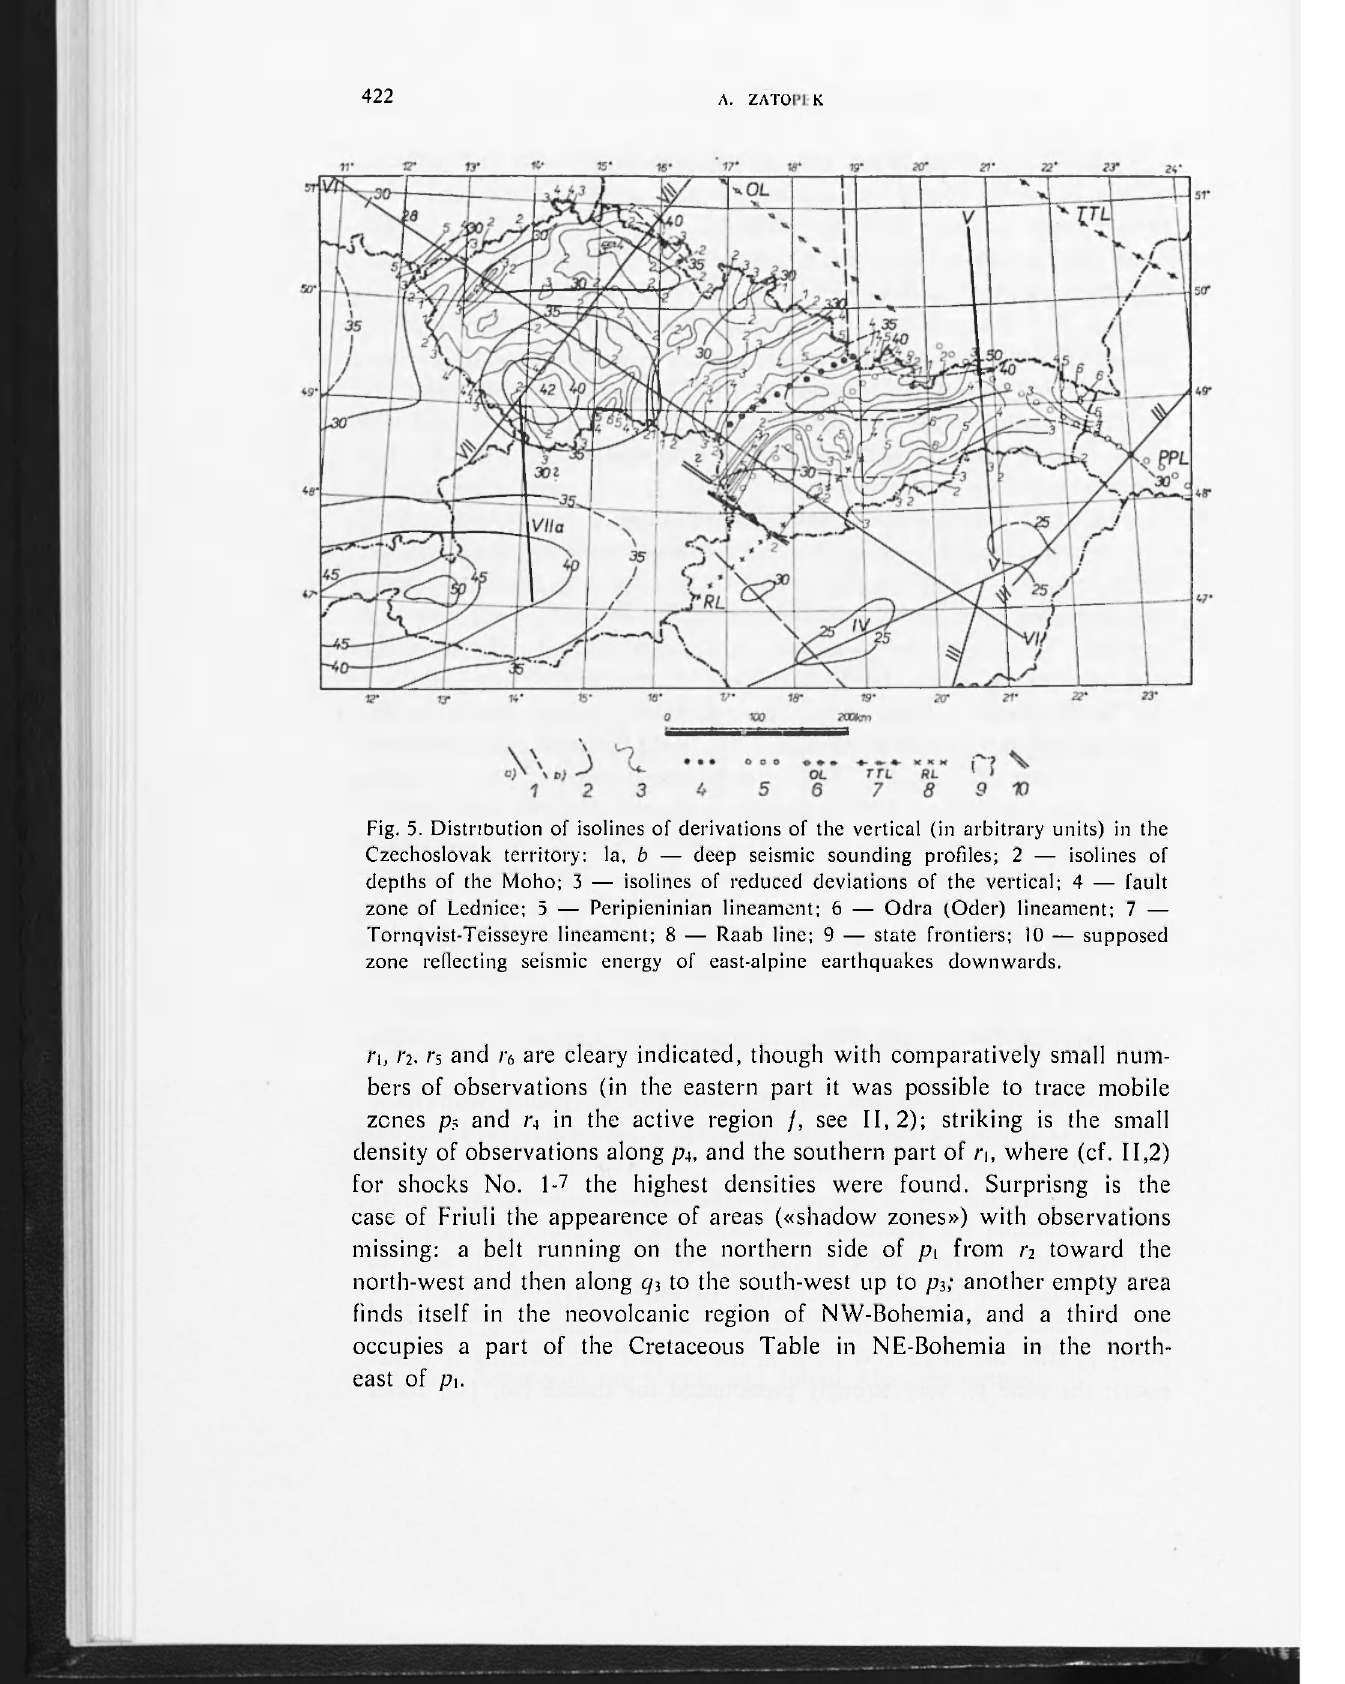
Fig. 5. Distribution of isolines of derivations of the vertical (in arbitrary units) in the Czechoslovak territory: la, b — deep seismic sounding profiles; 2 — isolines of depths of the Moho; 3 — isolines of reduced deviations of the vertical; 4 — fault zone of Lednice; 5 — Peripieninian lineament; 6 — Odra (Oder) lineament; 7 — Tornqvist-Teisseyre lineament; 8 — Raab line; 9 — state frontiers; 10 — supposed zone reflecting seismic energy of east-alpine earthquakes